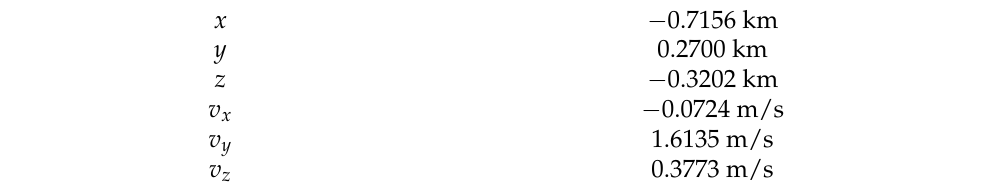
Table 8. Mid-inclination eccentric LEO formation: J 2 -invariant initial state of deputy